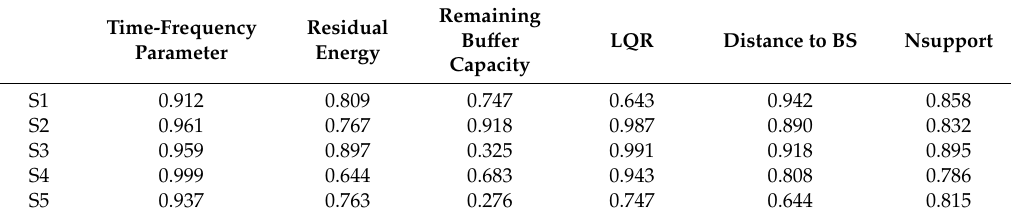
Table 5. Entropy matrix.